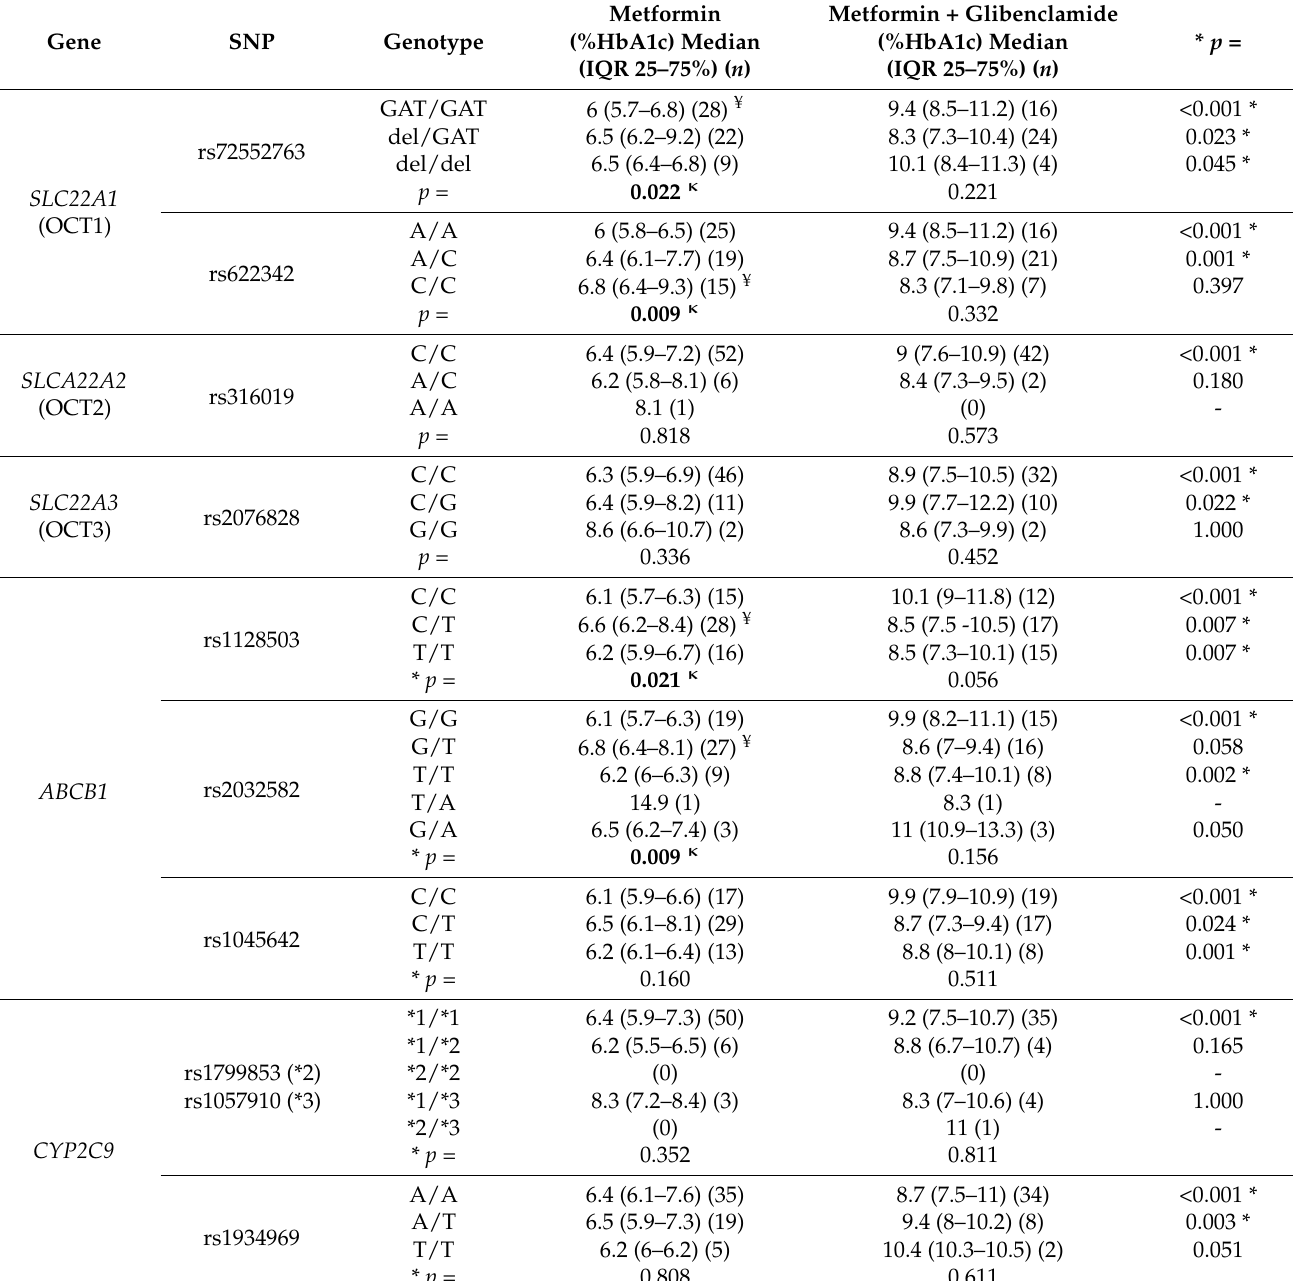
Table 5. Glycated hemoglobin (HbA1c) among DMT2 patients grouped by treatment and